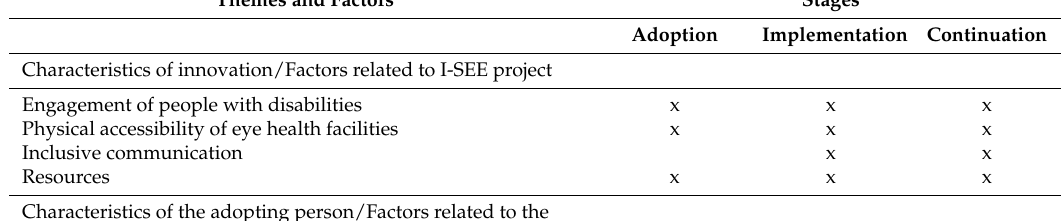
Table 2. Factors influencing the introduction of I-SEE project and the different stages. Themes and Factors Stages